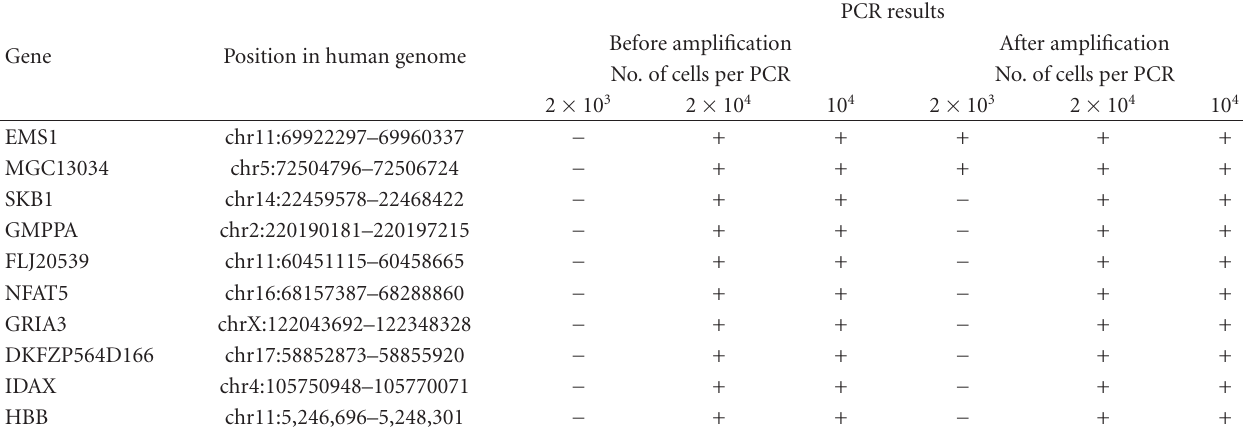
Table 2: PCR analysis of nonarrayed library amplification.